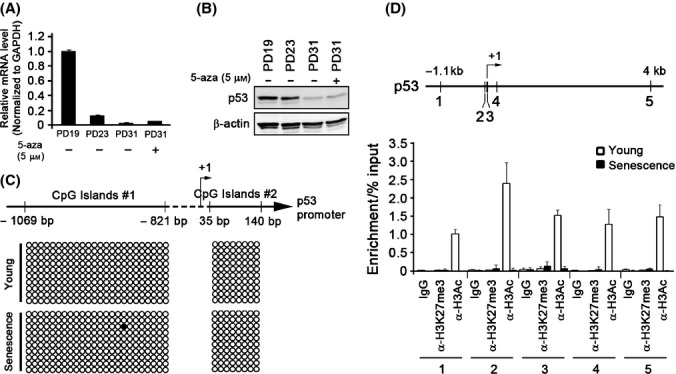
p53 is epigenetically regulated via histone deacetylation during replicative senescence. Senescent normal human keratinocytes (NHKs) were treated with 5-aza-CdR (5 μm) for 5 days. These cells, along with the same strain of NHKs at different PDs, were subjected to qRT–PCR (A) and Western blotting (B) to examine p53 expression. (C) Bisulfite sequencing assay was performed at two CpG islands in the p53 promoter regions in young and senescent NHKs. Ten samples were cloned and sequenced to confirm methylation status of the p53 promoter DNA at CpG islands #1 and #2. (D) The ChIP assay was performed in young and senescent NHKs using anti-H3Ac and anti-H3K27me3 antibodies, and the resultant DNA fragments were PCR-amplified using 5 different primers specific to the p53 promoter region (upper panel). The presence of p53 promoter DNA was evaluated using qRT–PCR (lower panel).